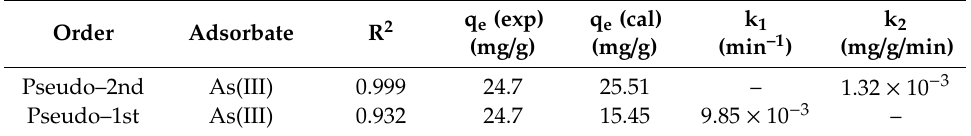
Figure 5. Adsorption kinetics curves for As(III) using PP@TiO 2 : ( a ) equilibrium concentration and % adsorption of As(III) as a function of time; ( b )adsorption capacity (qt) with contact time; ( c ) pseudo-1st-order kinetics plot for As(III) adsorption; ( d ) pseudo-2nd-order kinetics plot for As(III) adsorption. (Conditions: m = 25 mg, V = 25 mL, V / m = 1000 mL / g, concentration of As(III) = 30.20 mg / L, pH = 7, T = 25 ◦ C). Table 3. Kinetic parameters for the adsorption of As(III) onto PP@TiO 2